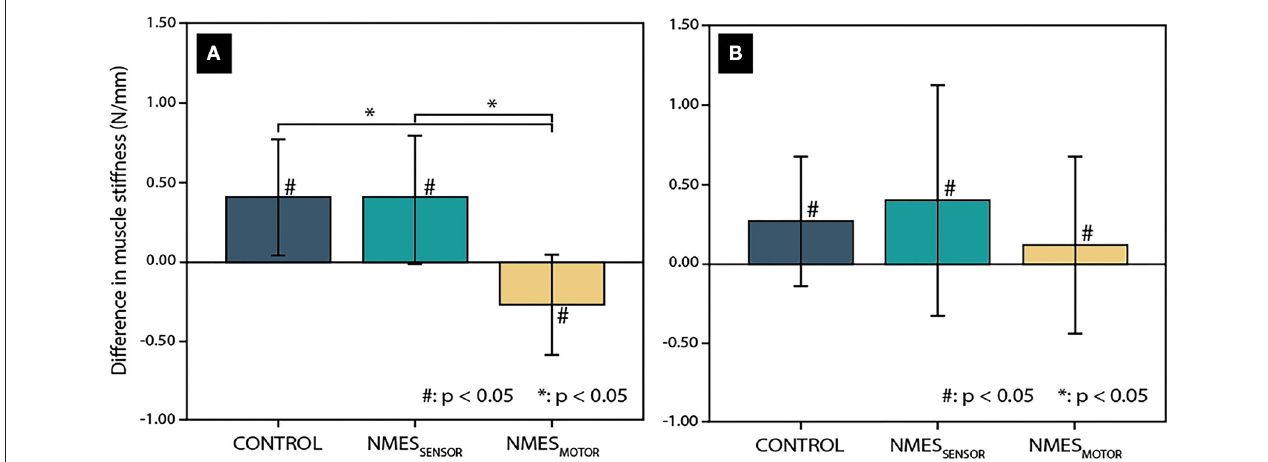
FIGURE 2 | Change in muscle tissue stiffness after a 4.5-h sitting period in the lumbar spine (A) and thoracic spine (B) for the three conditions (CONTROL: without neuromuscular electrical stimulation, NMES SENSOR : neuromuscular electrical stimulation at the sensory threshold, and NMES MOTOR : neuromuscular electrical stimulation at the motor threshold.) Significant differences related to the sitting period are indicated by a hash sign (#), while an asterisk (*) indicates significant differences between the tested